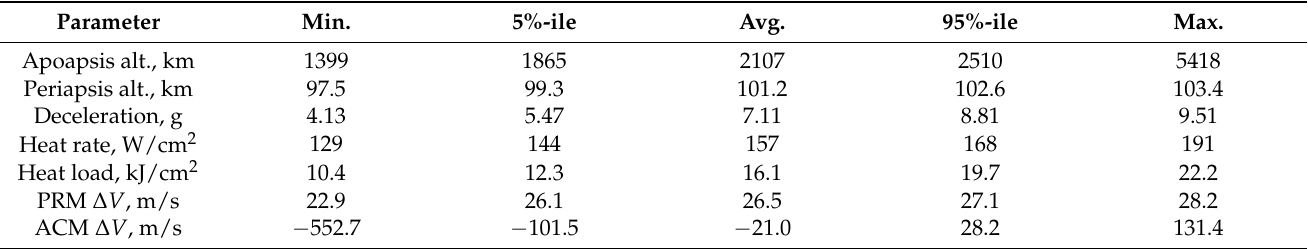
Table 12. Statistics from Venus aerocapture Monte Carlo simulations.